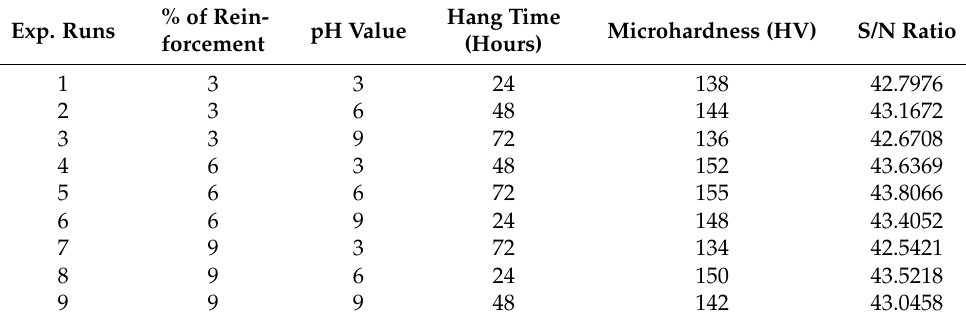
Table 18. Experimental summary of microhardness